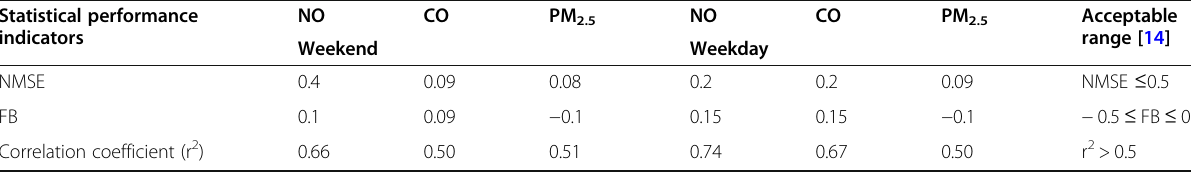
Table 3 Statistical performance of the CALINE4 Statistical performance